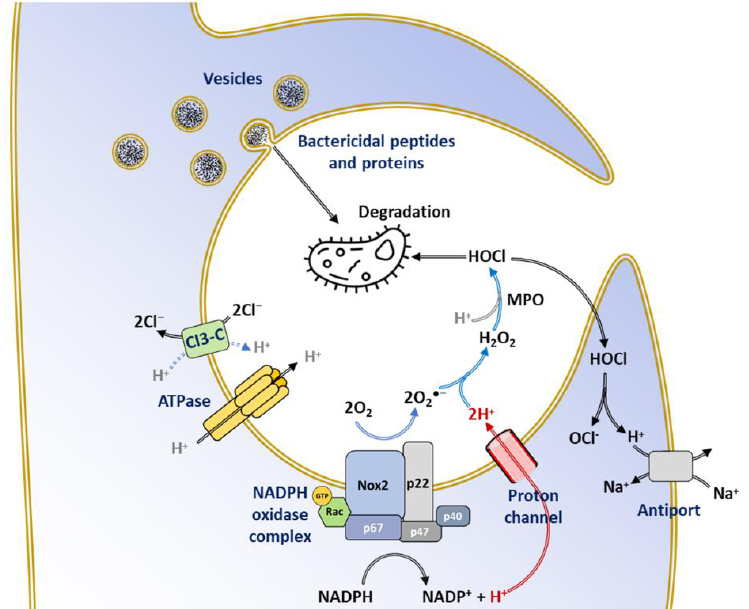
Figure 14. Main roles of ROS produced by NOX2 during the oxidative burst. During phagocytosis, a bacterium is sequestered in the phagosome triggering the release of bactericidal content from several types of vesicles. NOX2 transmembrane electron flow is balanced by proton flow through voltage-gated proton channels. This provides protons to the phagosome interior for the conversion of O 2●− to H 2 O 2 and HOCl and relieves the cytoplasm of protons released by the oxidation of NADPH. Other transporters, including ClC-3 (a Cl/H + antiporter), H + -ATPase and the Na + /H + antiporter, also contribute to pHi recovery. Adapted from [239,240].